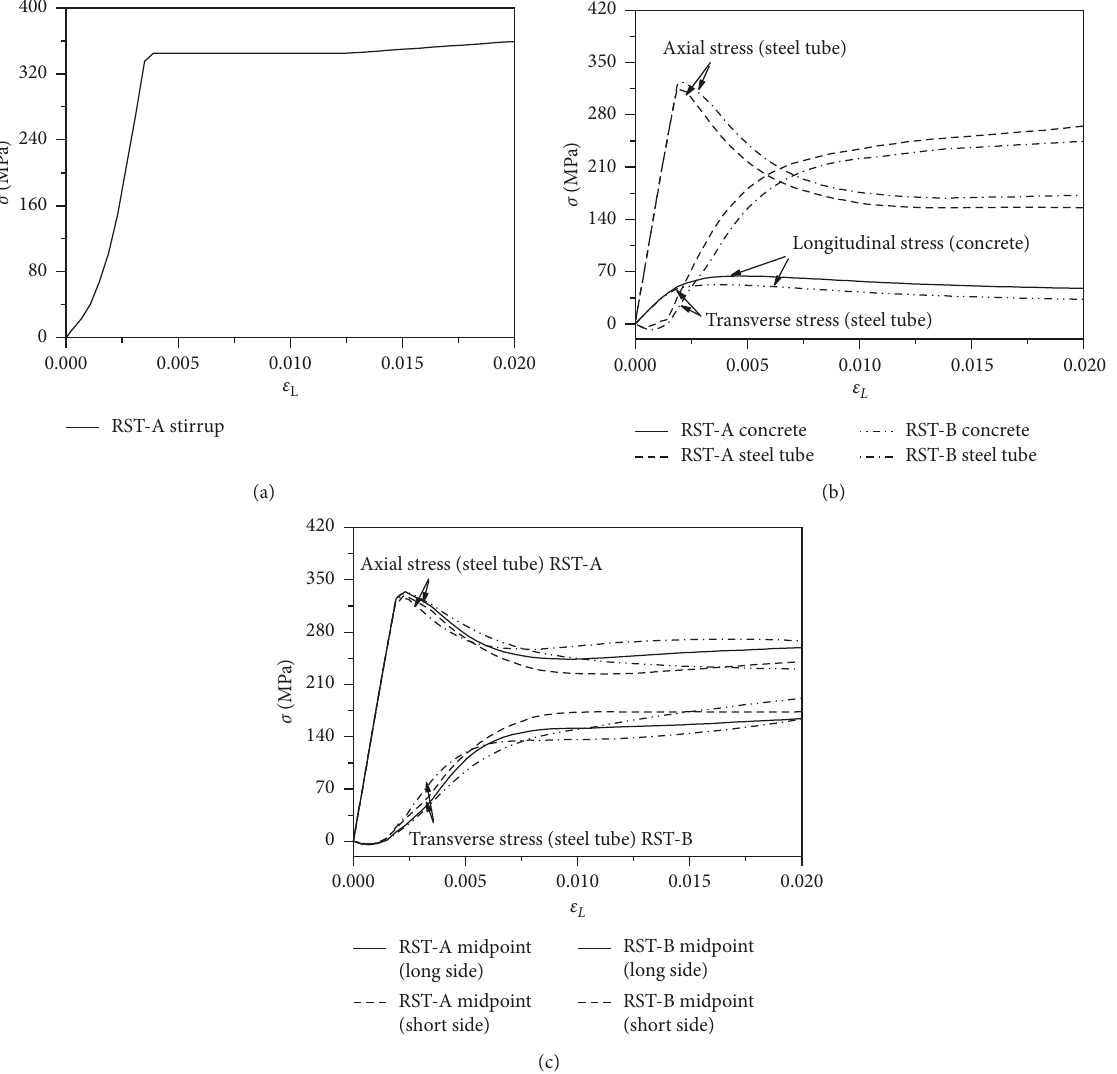
Figure 10: Comparison of the relationship between the stress and longitudinal strain of specimens. (a) Stress-strain relationship of the elliptical stirrup in the middle section. (b) Comparison of stresses at the endpoints of the concrete and steel tubes. (c) Comparison of stresses at the midpoints of steel